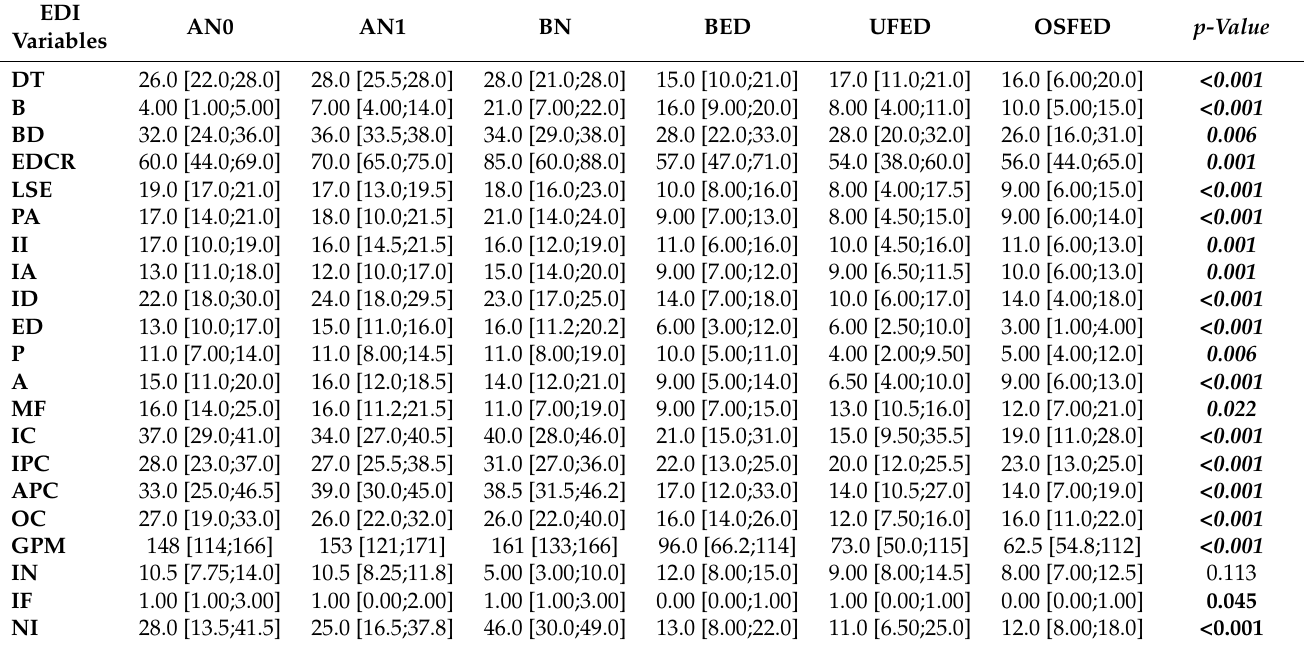
Table 5. Psychopathological data for ED patients. Descriptive statistics by groups of diagnosis for